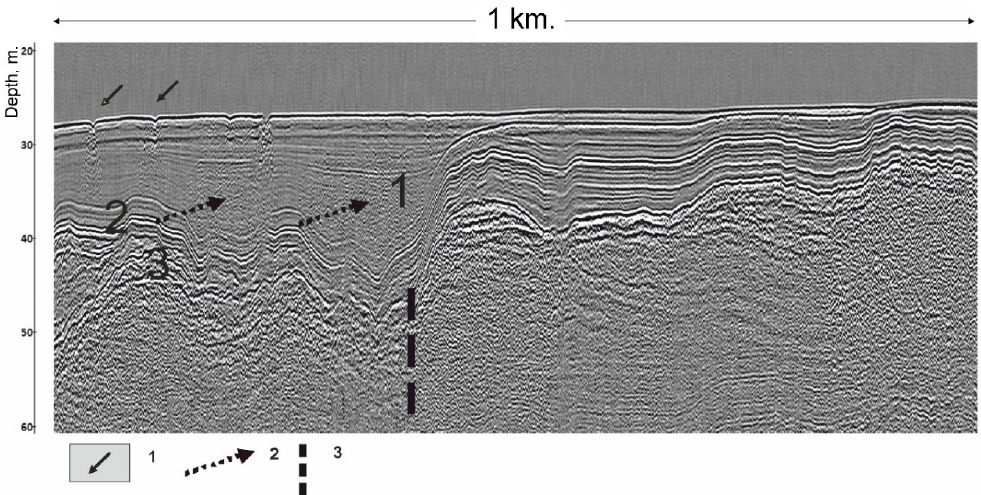
Figure 3. The seismic profile (the position, see Figure 1) with a sharp shift of the roof of limno-glacial (varved) clays caused by tectonic dislocation (thick dashed line). The figures in the seismic record show the following: 1: Holocene lacustrine muds; 2: limno-glacial clays; 3: till of the Valday (Weichselian) Glacial stage. Dashed arrows indicate large areas of gas accumulation and solid arrows indicate pockmarks.